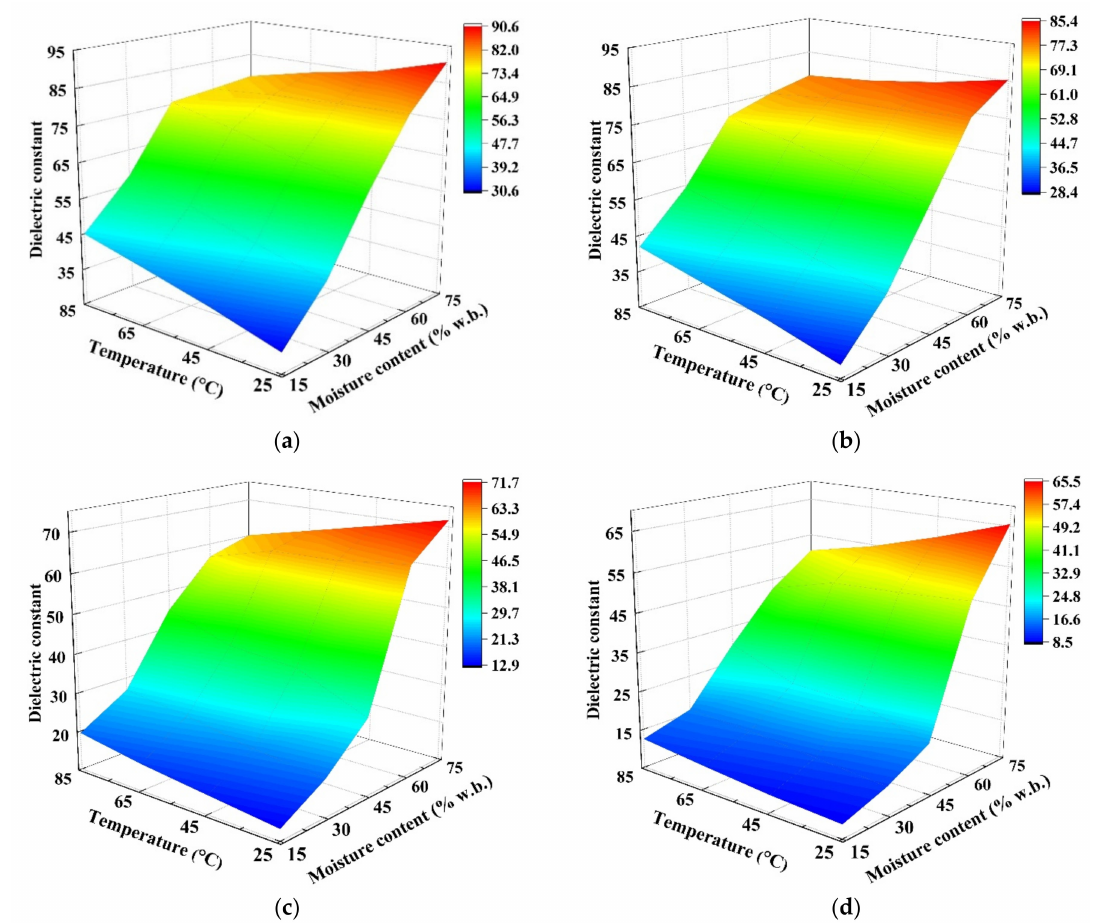
Figure 4. Moisture- and temperature-dependent dielectric constant ( ε (cid:48) ) of wolfberries at 27 ( a ), 40 ( b ), 915 ( c ), and 2450 MHz ( d